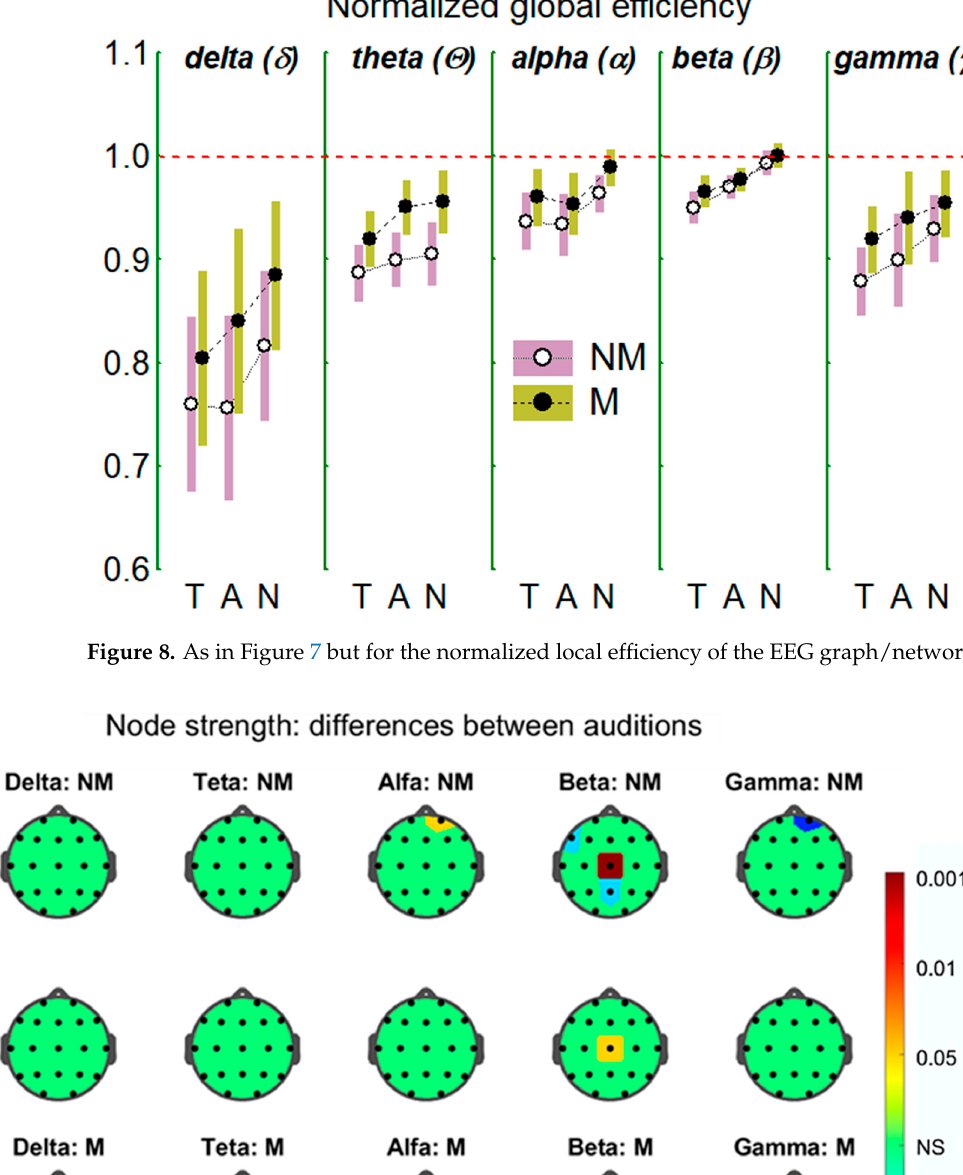
Figure 7. As in Figure 5 but for the normalized local efficiency of the EEG graph/network. The red line indicates the limit value for a random network according to the selected normalization process.